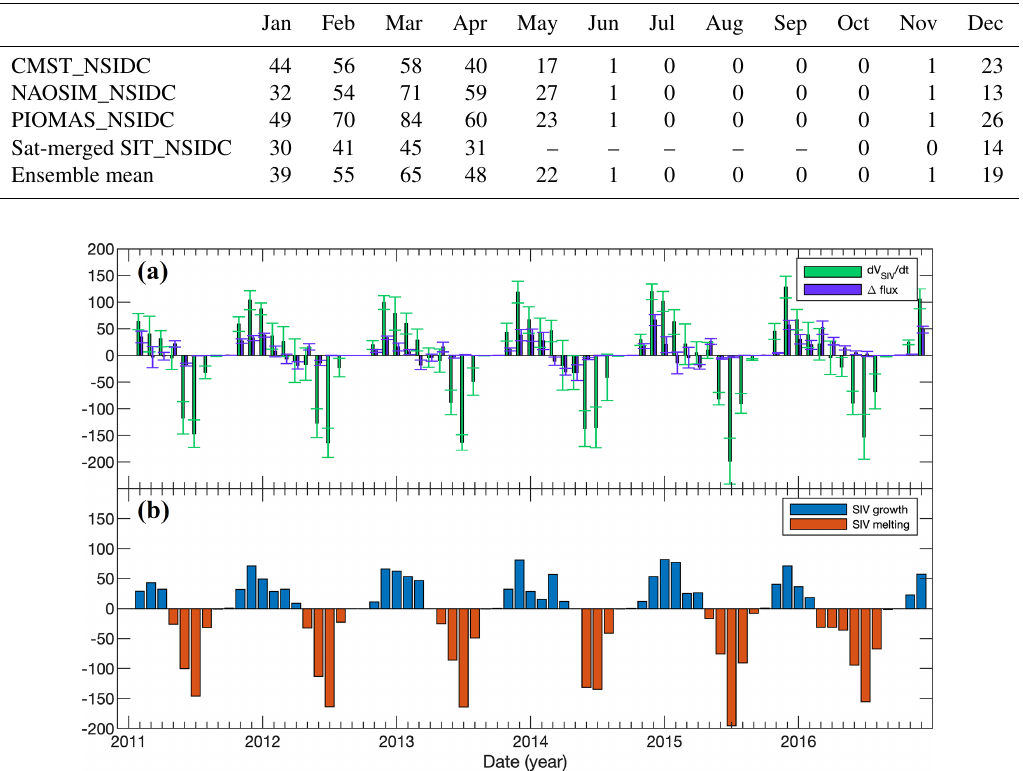
Table 1. Monthly mean freshwater fluxes (km 3 month − 1 ) imported into the Labrador Sea that derive from the sea-ice volume outflow.